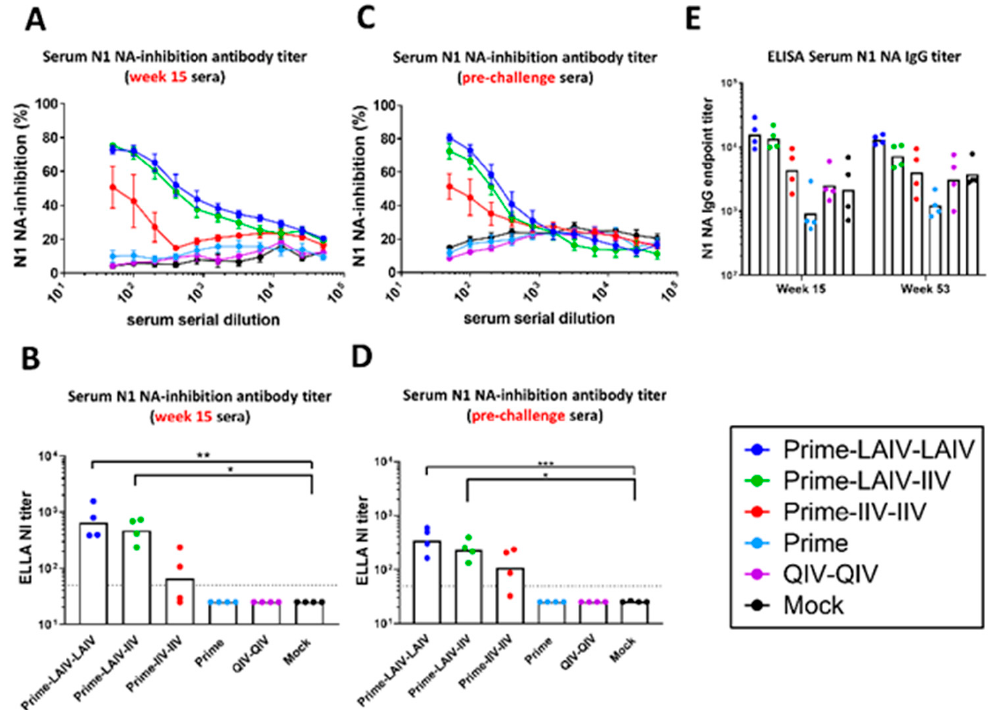
Figure 4. N1 neuraminidase-inhibiting and anti-N1 NA antibody responses measured by ELLA and ELISA. ( A – D ) Fetuin-based enzyme-linked lectin assays (ELLA) were used to measure NA-inhibiting (NI)-antibody titers, which are reported as reductions in the N1 NA enzymatic activities of the H7N1 viruses. The N1 NA-inhibition curves on weeks ( A ) 15 and ( C ) 53 (pre-challenge) are graphed. ELLA NI titers were measured at weeks ( B ) 15 and ( D ) 53 (pre-challenge) and are reported as the 50% reduction in the NA enzymatic activities of H7malN1Cal09 virus strain. ( E ) ELISA serum IgG endpoint titers (y-axis) against N1 NA on weeks 15 and 53 (pre-challenge) are indicated. LAIV-LAIV, LAIV-IIV, IIV-IIV, Prime only, and QIV-QIV vaccinated animals are shown as blue, green, red, light blue, and purple, respectively. Mock-immunized animals are shown as black. All animals except for QIV- and mock-immunized ferrets were primed with B-cH9/1 virus. White bars indicate the GMT with individual scatter dot plots. Each point indicates the endpoint titer for each individual ferret ( n = 4/group). Data were compared to mock vaccinated animals with one-way or two-way ANOVA followed by a Dunnett’s multiple comparison test. The asterisks refer to the level of significance: *: p < 0.05; **: p < 0.01; ***: p < 0.001. The black dashed line indicates the limit of detection for the assay.